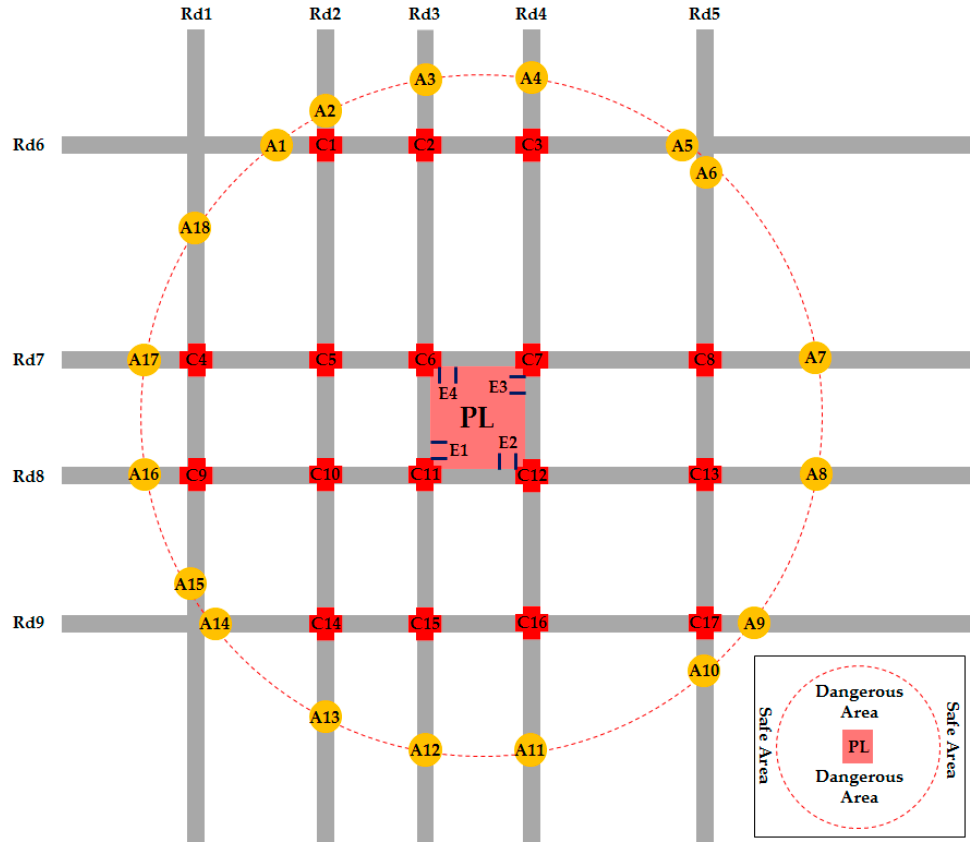
Figure 4. Configuration of the parking lot and road network layout.